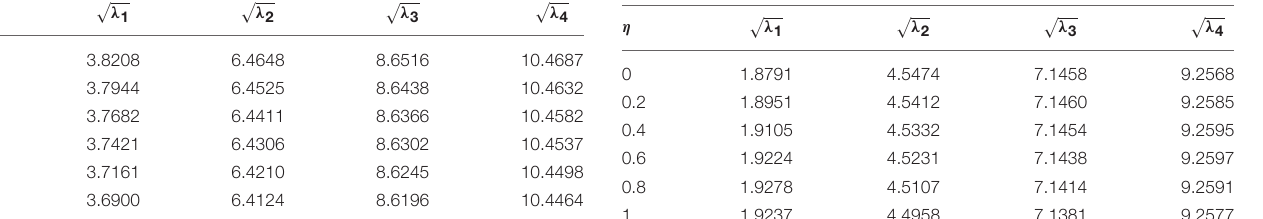
TABLE 16 | Frequency parameters parameters.